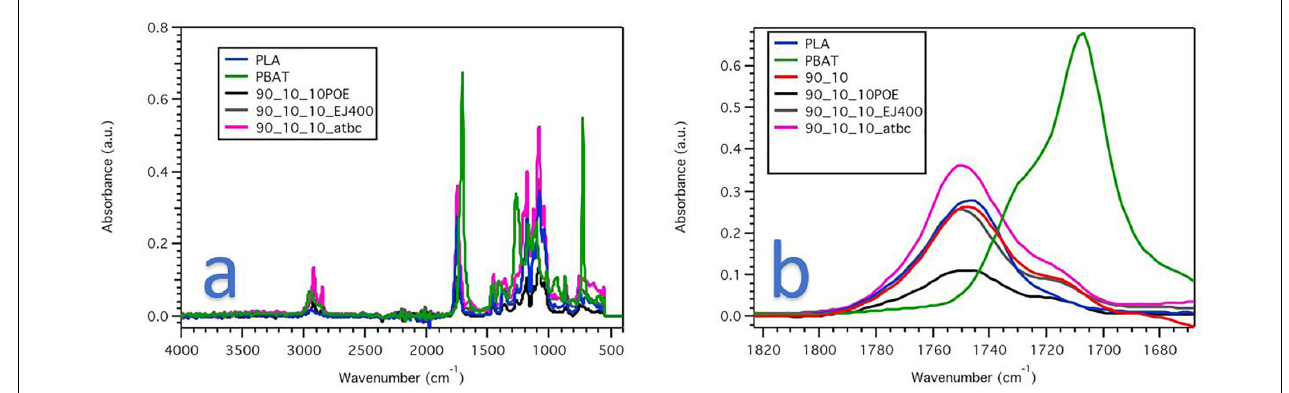
FIGURE 10 | (A) ATR spectra of binary and ternary blends and (B) detail of the 1700–1800 cm - 1 range.